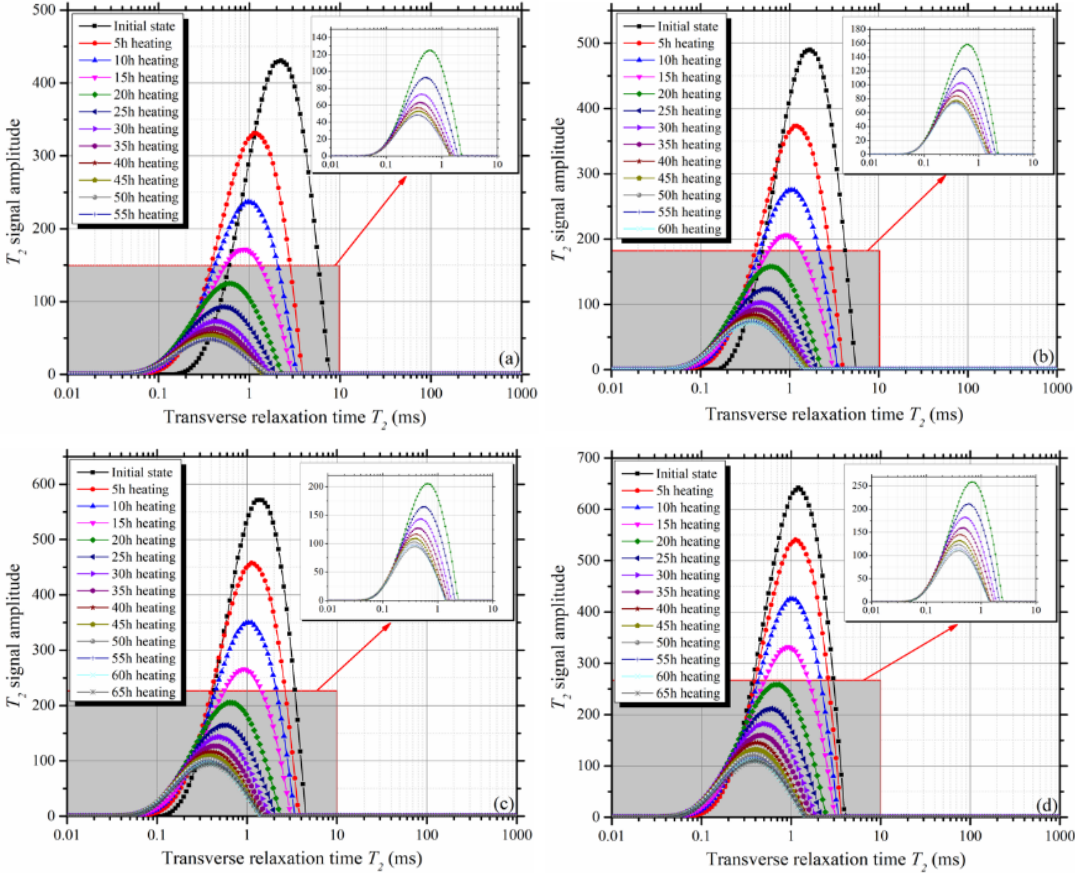
Figure 6. The variation of T 2 spectra of montmorillonite-quartz mixtures: ( a ) M40; ( b ) M60; ( c ) M80; ( d ) M100. In ( a – d ), from top to bottom, curves with di ff erent colors and symbols with di ff erent shapes indicate T 2 spectra of montmorillonite-quartz mixtures after heating at di ff erent times. The T 2 spectra in the box were enlarged and placed in the upper right corner of ( a – d ).